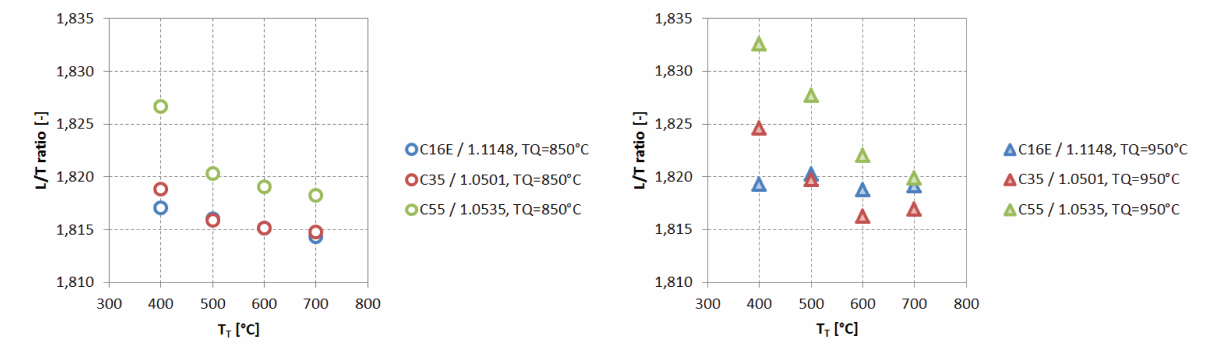
Figure 4. Measured L/T ratio values grouped by quenching temperatures. C16E (blue) had in general the lowest L/T ratio values, C35 (red) average and C55 (green) the highest for both quenching temperatures T Q = 850 °C (circle) and T Q = 950 °C (triangle).